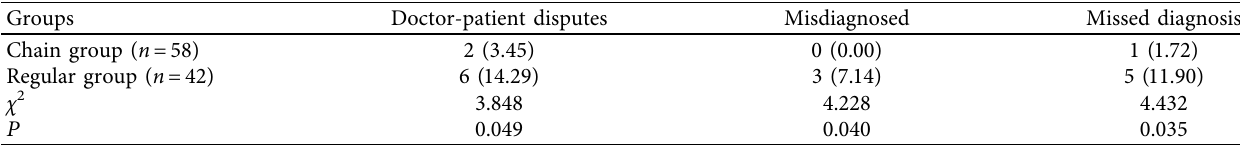
Table 2: Comparison of the incidence of adverse events between the two groups ( n (%)).